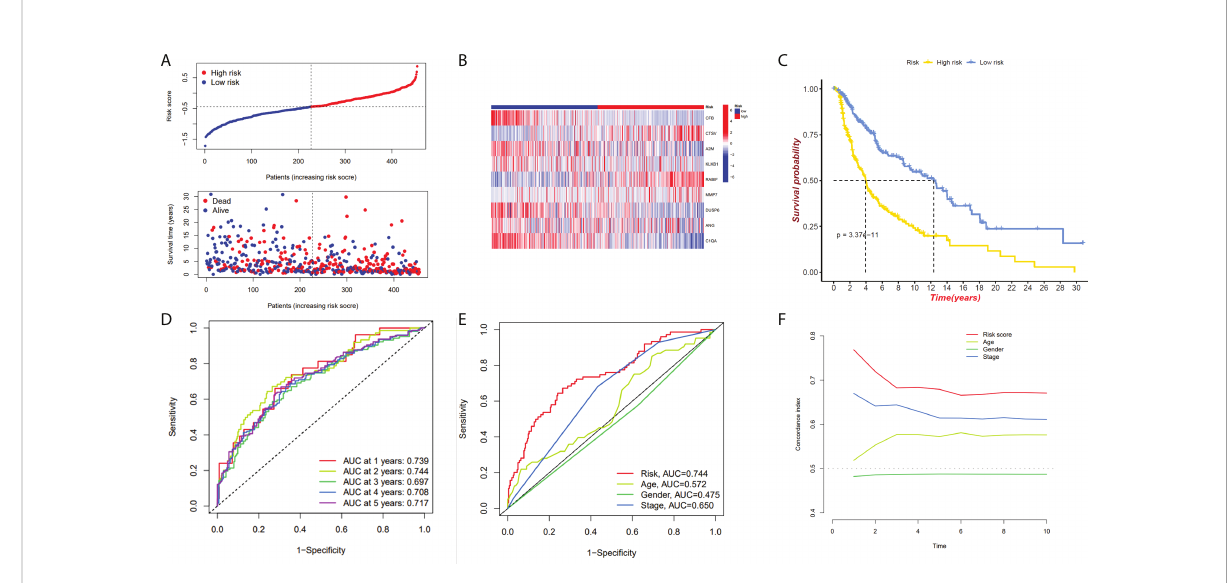
FIGURE 3 The 7-gene model in the TCGA cohort prognostic analysis. (A, B) Risk score distribution and the relevant survival data and the TCGA cohort ’ s heat map of prognostic genes expression. (C) The Kaplan – Meier curve analysis of the TCGA cohort ’ s high and low-risk groups. (D) The AUCs under ROC curves for 1-, 3-, and 5-year OS predictions based on the risk model. (E) ROC relating risk scores with clinical indicators of pathology. (F) C-index comparison between risk score and clinical features (age, gender, and stage).